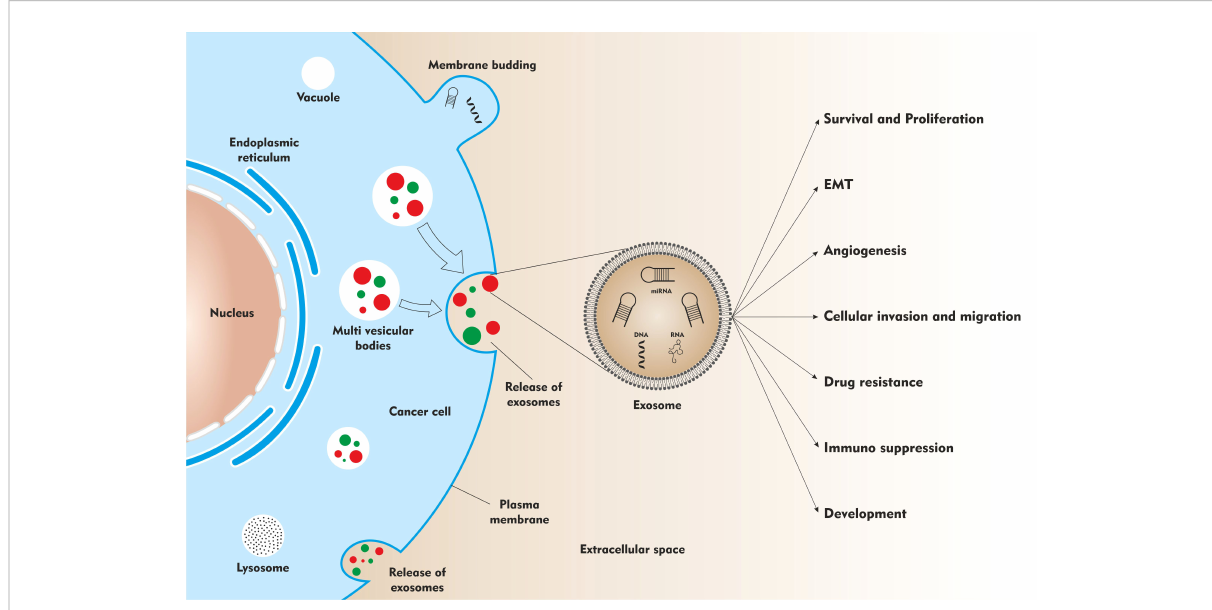
FIGURE 1 The role of exosomes in neuroblastoma development and